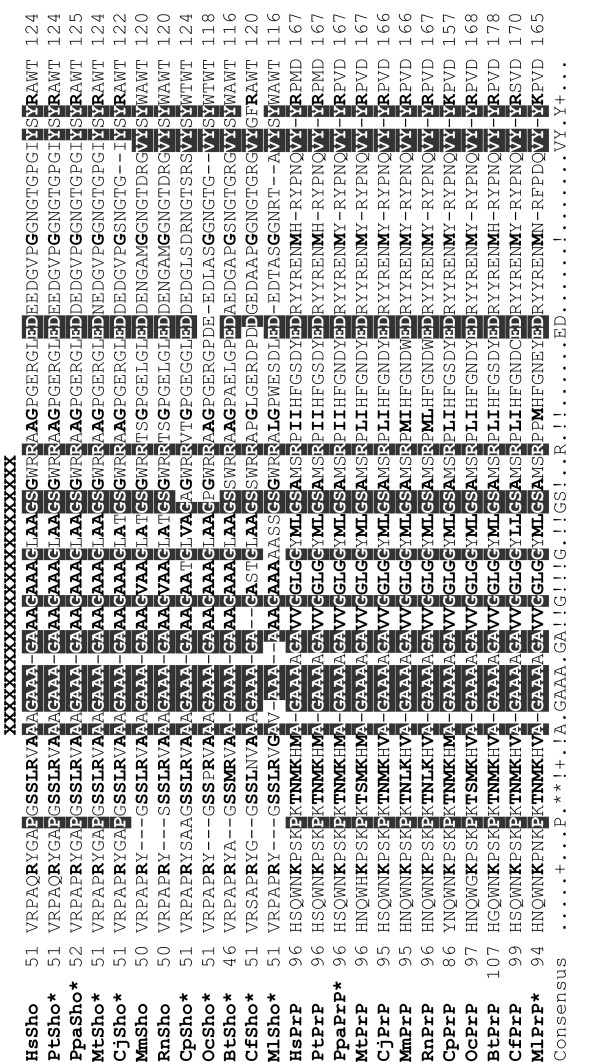
The conserved plastic PrP region compared with Shos. White letters on black background, conserved amino acids; bold, similar amino acids. X indicates residue in the highly conserved potential transmembrane region. In the consensus line: capital letters, conserved amino acids; +, conserved basic residues; *, conserved polar residues; !, conserved hydrophobic residues. Bt, Bos taurus; Cf, Canis familiaris; Cj, Callithrix jacchus; Cp, Cavia porcellus; Hs, Homo sapiens; Mm, Mus musculus; Mt, Macaca mulatta; Oc, Oryctolagus cuniculus; Ppa, Pongo pygmaeus abelii; Pt, Pan troglodytes; Rn, Rattus norvegicus. *, sequence annotated in this study.